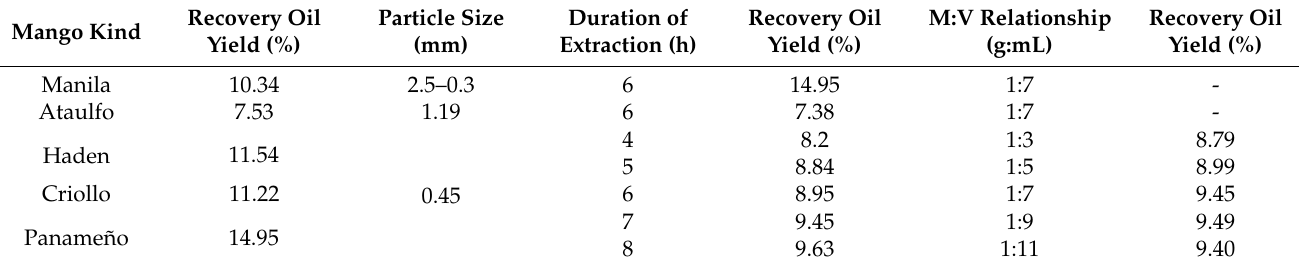
Table 2. Optimization of parameters in the oil extraction.